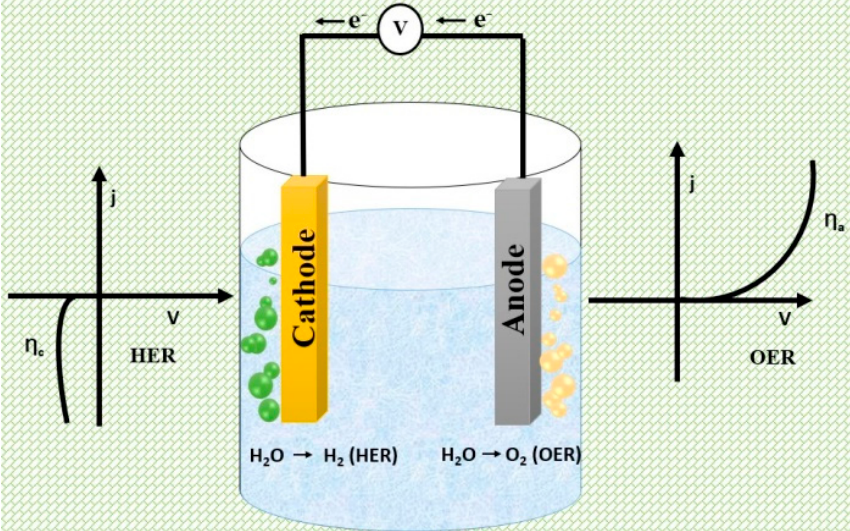
Figure 14. Schematic diagram of electrocatalytic (EC) water splitting.